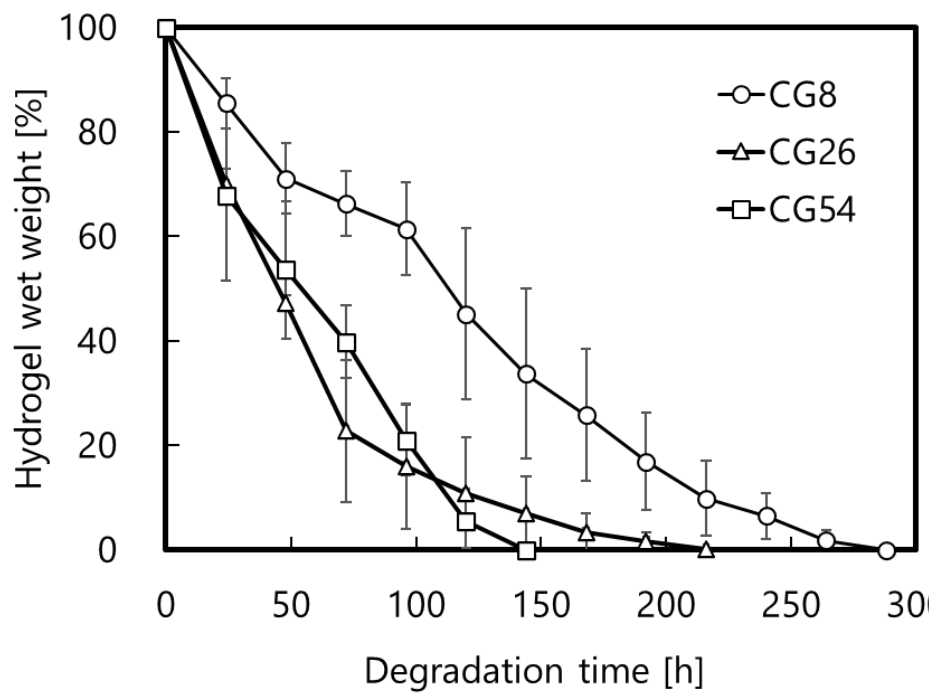
Figure 4. The degradation rate of CG8, CG26, and CG54 AC hydrogels by lysozyme (n = 4).